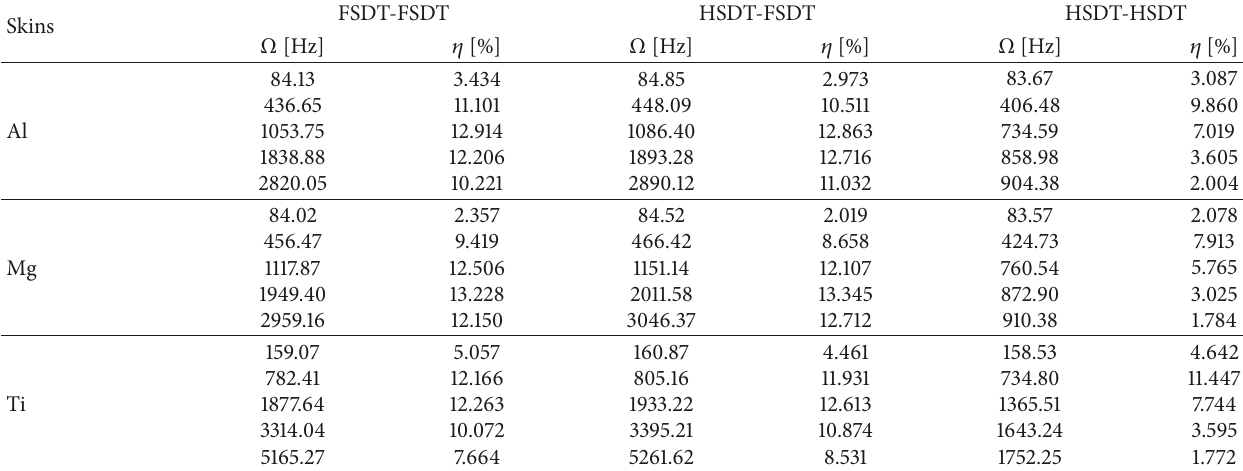
Table 8: Frequencies Ω and loss factors 𝜂 . Cantilever